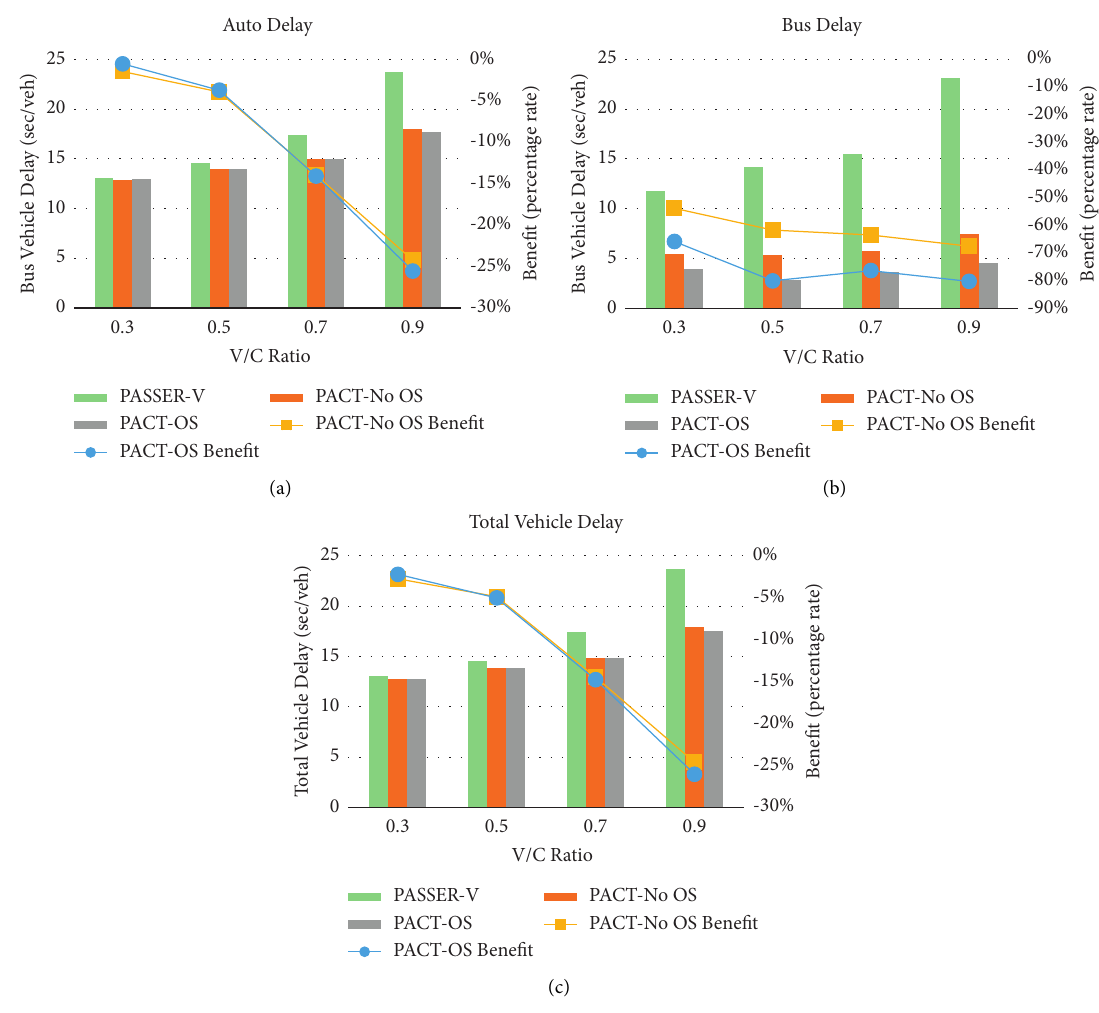
Figure 13: Delay changes in (a) auto, (b) bus, and (c) total vehicle under various V/C ratios.